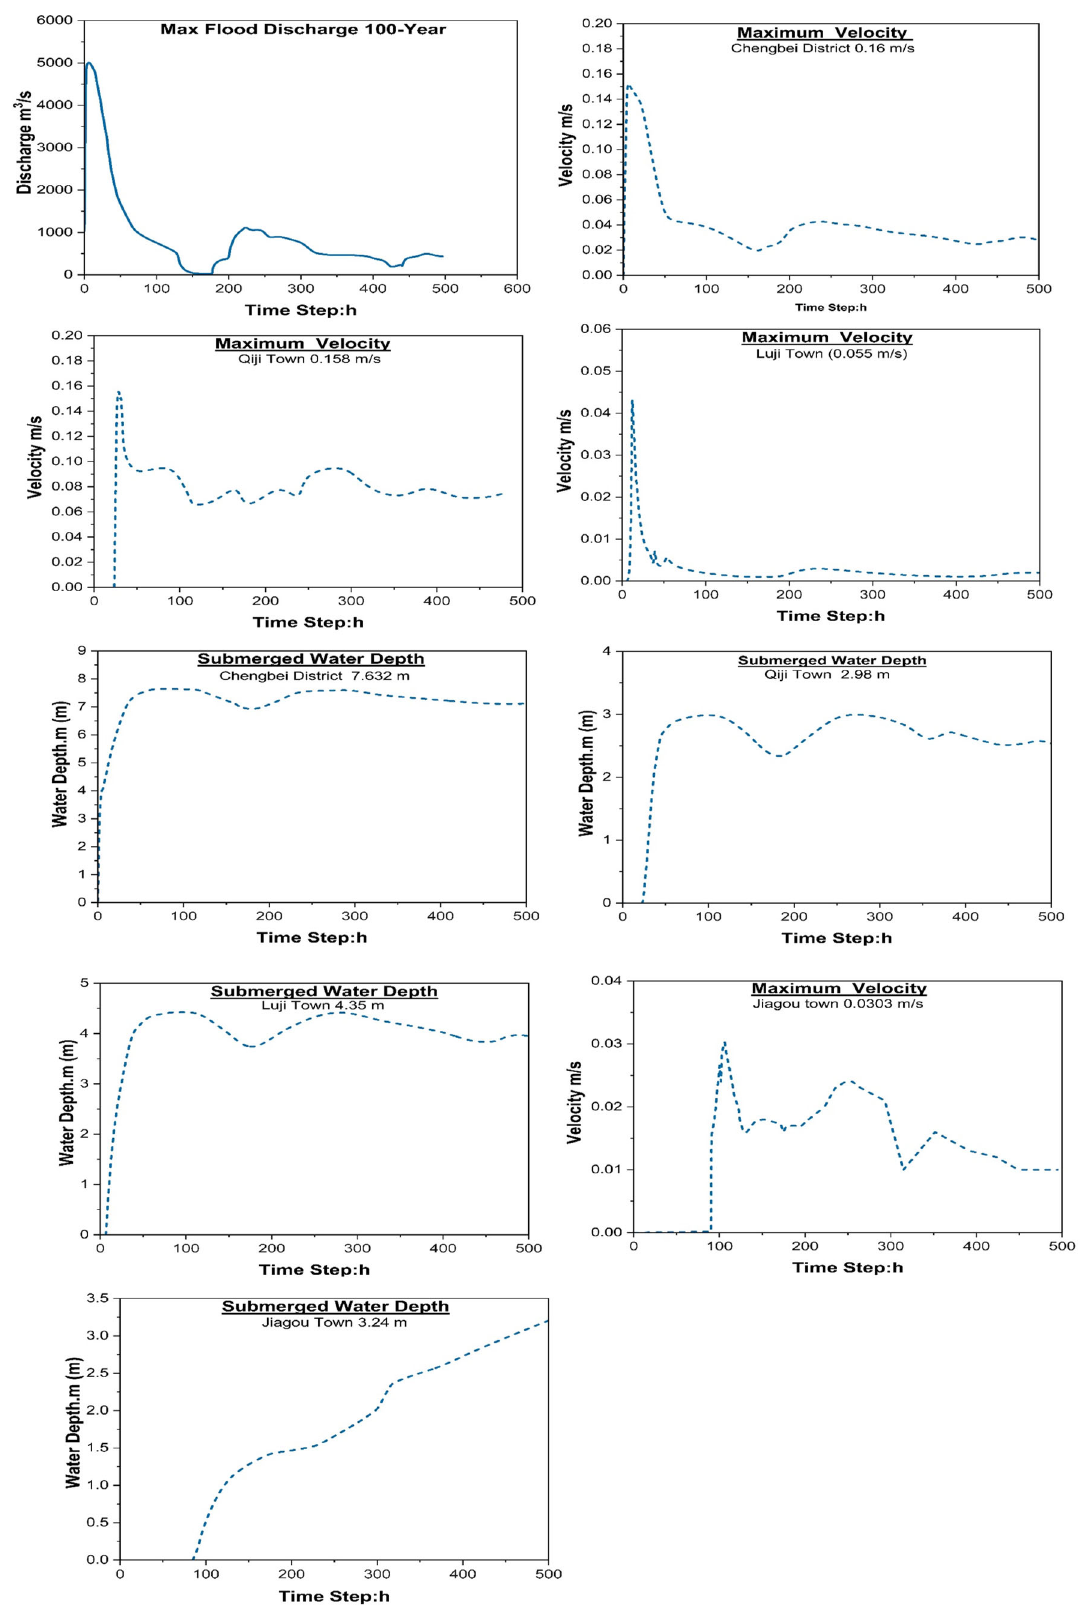
Figure 6. Frequency of flood discharge, velocity, and submerged water depth graphs of 100-year flood at Chengbei District, Qiji Town, Luji Town, and Jiagou Town.